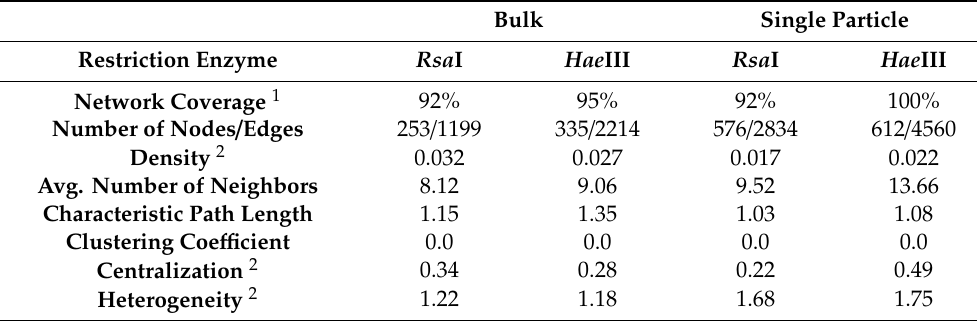
Table 3. Topological parameters of the association rule networks.